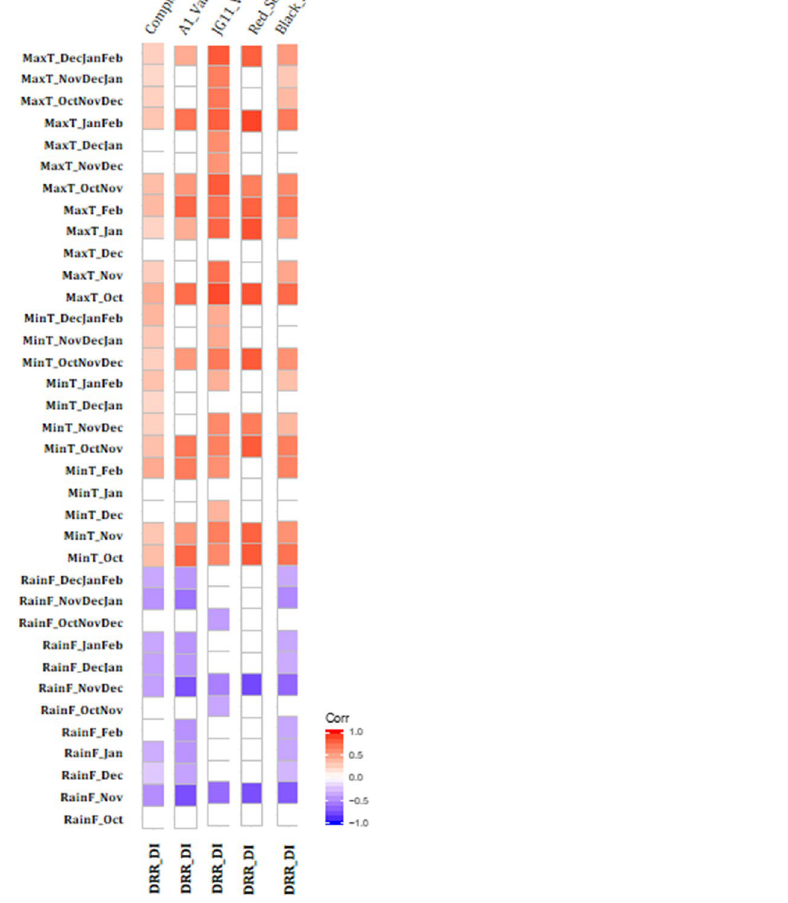
Figure 1. Correlation analyses between DRR disease incidence and weather parameters. Correlation analyses was performed using publicly available DRR disease incidence data to study the relation between DRR disease incidence and weather components; rainfall and temperature. DRR disease incidence data was gathered from published research articles and theses (Supplementary file S1, Supplementary Table S1). Weather data for the respective locations were acquired from Indian Meteorological Department. Weather data for the field trial season mentioned in the source was acquired, and the monthly average for the months from October to February for maximum and minimum temperature was calculated. Total monthly rainfall and total rainfall for the two and three consecutive months were also calculated. A correlation was performed using Pearson’s correlation method for all the possible weather factors and DRR Disease incidence (a). Correlation analyses was performed for complete DRR data set, and data set for the A1 genotype, JG11 genotype, red soil type and black soil type. Red boxes represents significant positive correlation, and blue boxes represent significant negative correlation, empty boxes represent no significant correlation. Correlation with p < 0.05 was taken as statistically significant. A negative correlation exists between DRR disease incidence and rainfall, while a positive correlation exists between disease incidence and minimum and maximum temperature. RainF = rainfall, MinT =